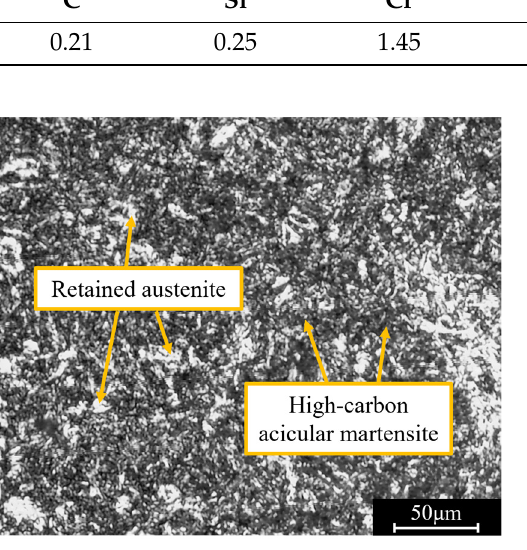
Figure 1. Microstructure in carburized layer of the 20Cr2Ni4A blank